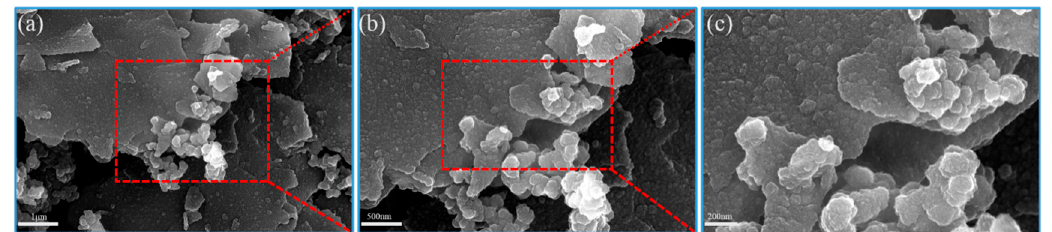
Figure 2. Different magnification SEM images of ( a – c ) rGO/CuS/PPy sample.